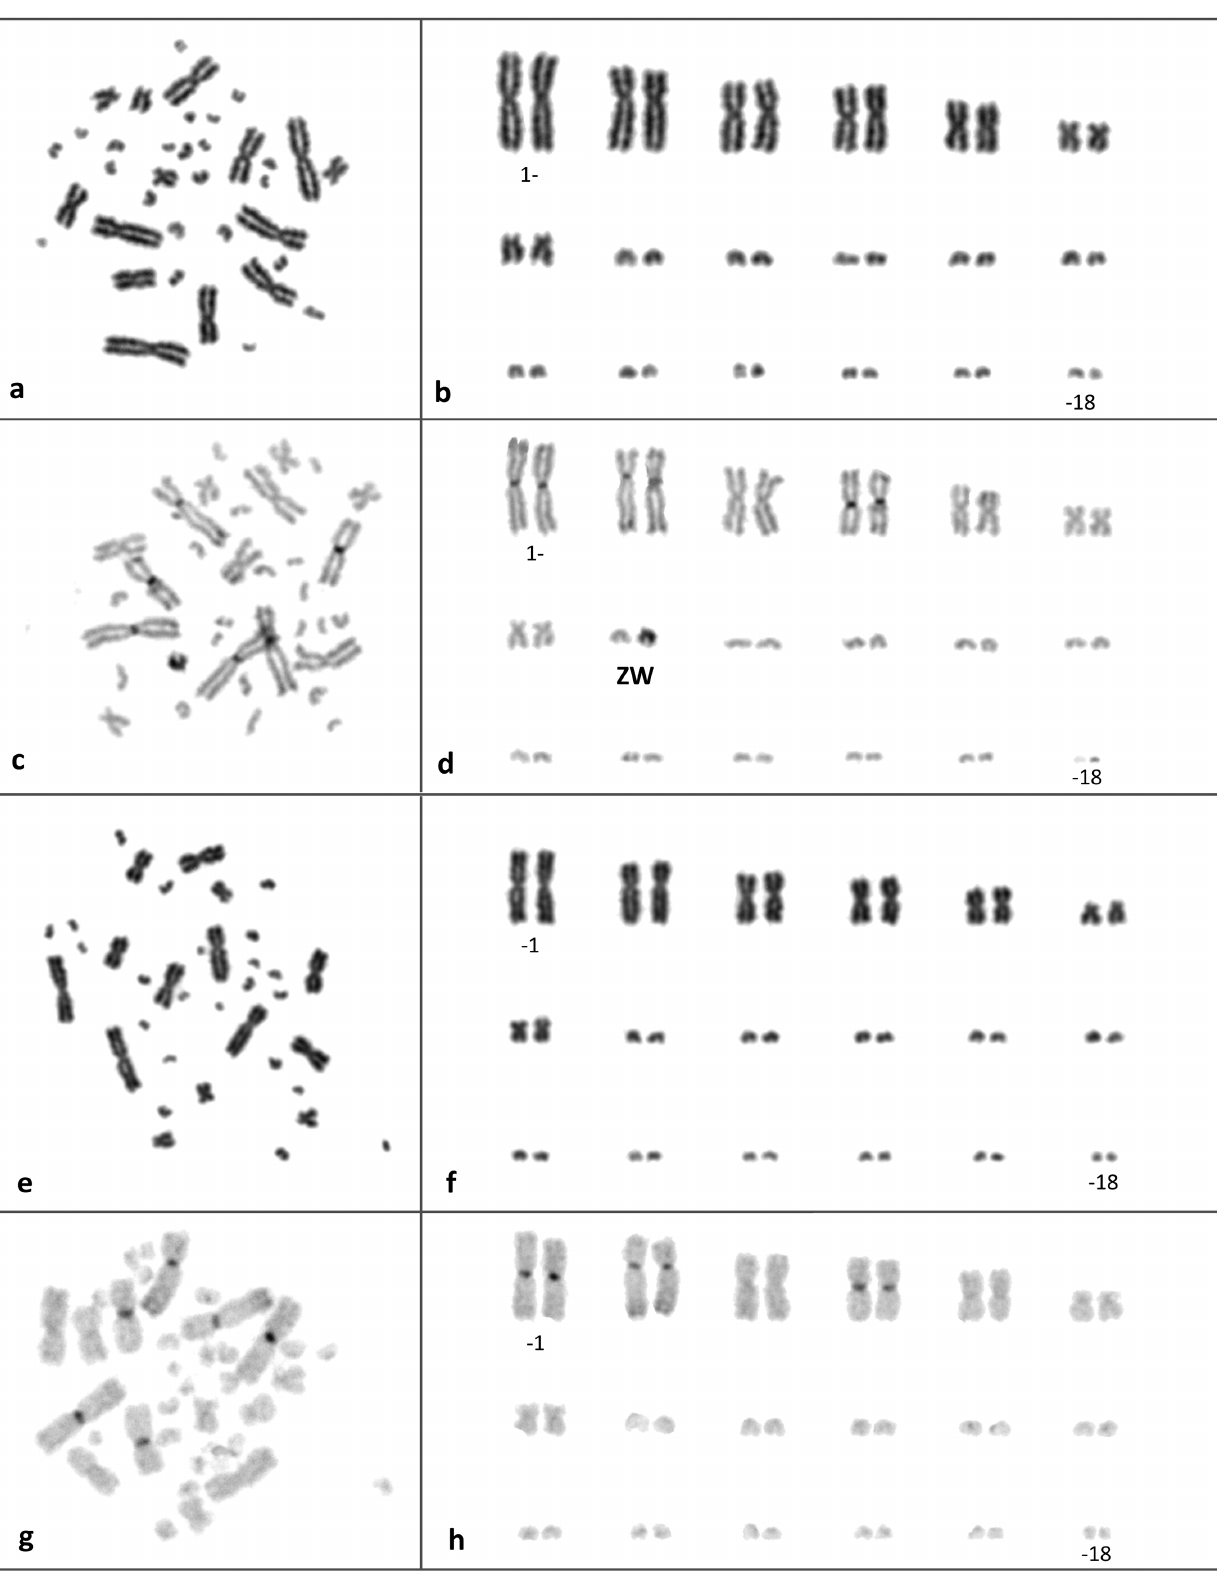
PLOS ONE | www.plosone.org